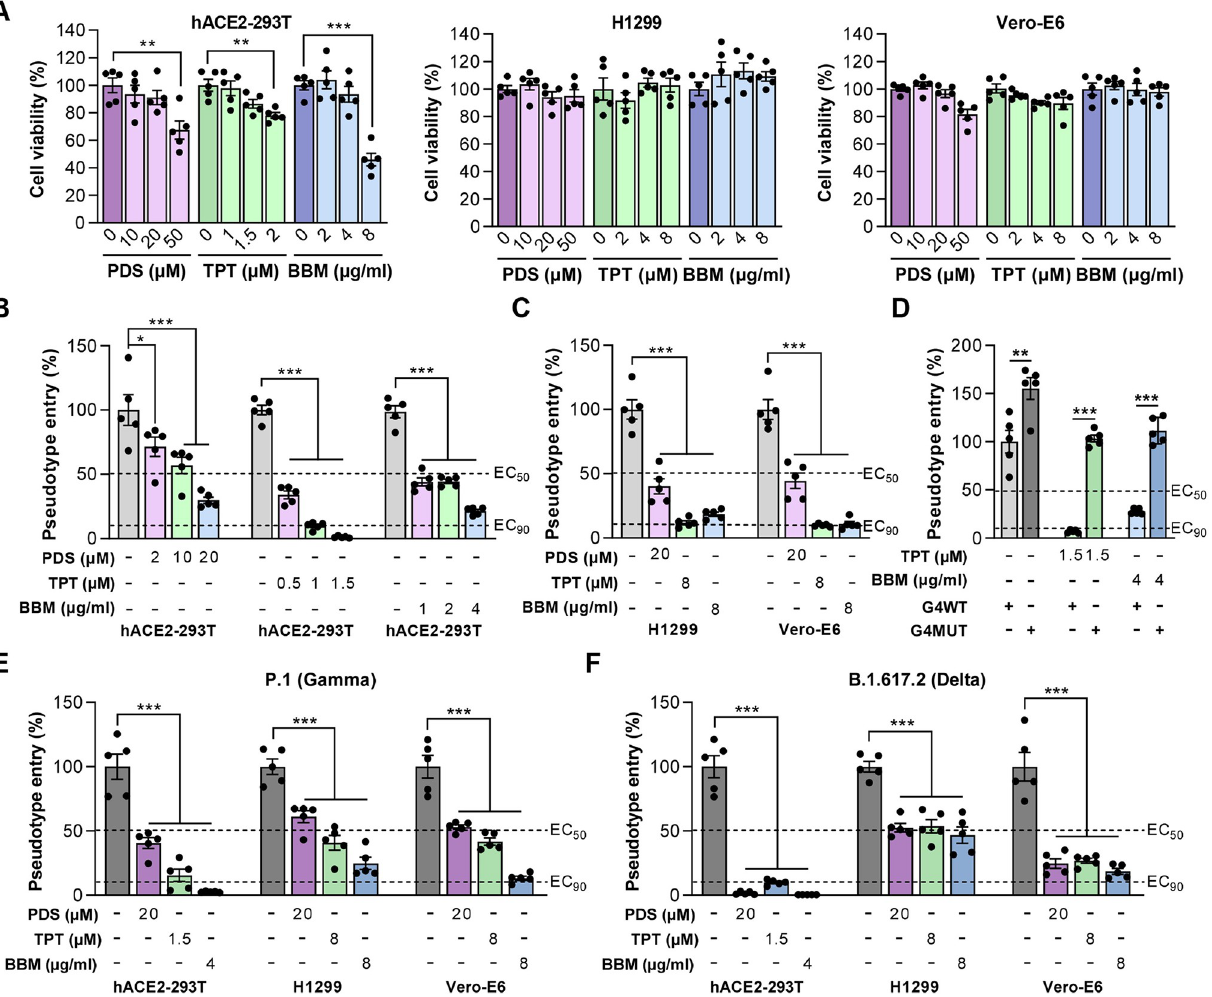
Fig 4. TPT and BBM block SARS-CoV-2 pseudovirus entry in vitro . (A) Relative cell viability of hACE2-293T (left panel), H1299 (middle panel), and Vero-E6 (right panel) cells treated with the indicated concentrations of PDS, TPT or BBM. (B, C) SARS-CoV-2 pseudovirus entry efficiency in hACE2- 293T (B), H1299 (C) and Vero-E6 (C) cells treated with the indicated concentrations of PDS, TPT, or BBM. Cells were pre-treated with indicated compounds and then infected with VSV-SARS-2-S-luc. 48 hrs post infection, pseudovirus entry was assessed by luciferase activity (normalization against untreated cells). (D) SARS-CoV-2 pseudovirus entry efficiency in hACE2-293T cells transfected with the plasmid pool of ACE2-/AXL-/FURIN-/ TMPRSS2-G4WT or their corresponding G4MUT plasmids and stimulated with TPT or BBM. (E, F) Entry efficiency of P.1 (E) and B.1.617.2 (F) variants in hACE2-293T, H1299, and Vero-E6 cells treated with the indicated concentrations of PDS, TPT, or BBM. Data are shown as mean ± SEM, n = 5. � p < 0.05, �� p < 0.01, ��� p < 0.001 (Two-tailed Student’s t test).